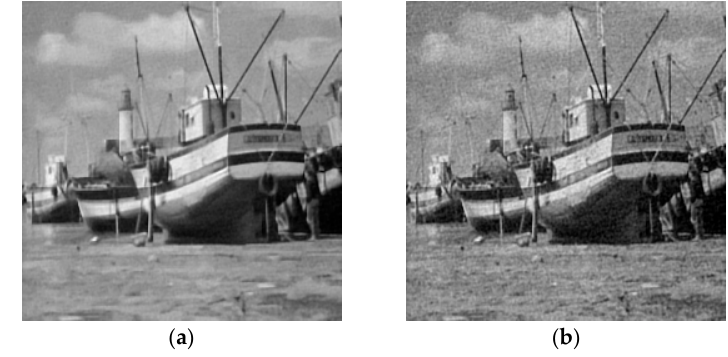
Figure 1. Visual intermediate results of ISTANR ( a ) and BAIST ( b ).